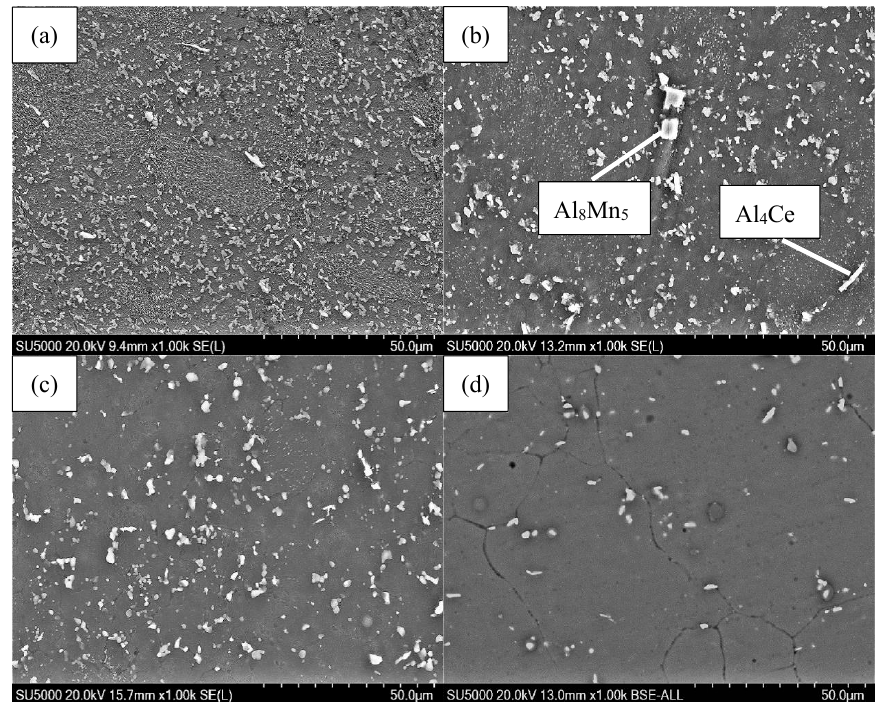
Figure 10. SEM images of AZ80 + 0.4%Ce magnesium alloy tubes after fourth pass with different temperatures: ( a ) 270 °C, ( b ) 310 °C, ( c ) 350 °C, ( d ) 390 °C.